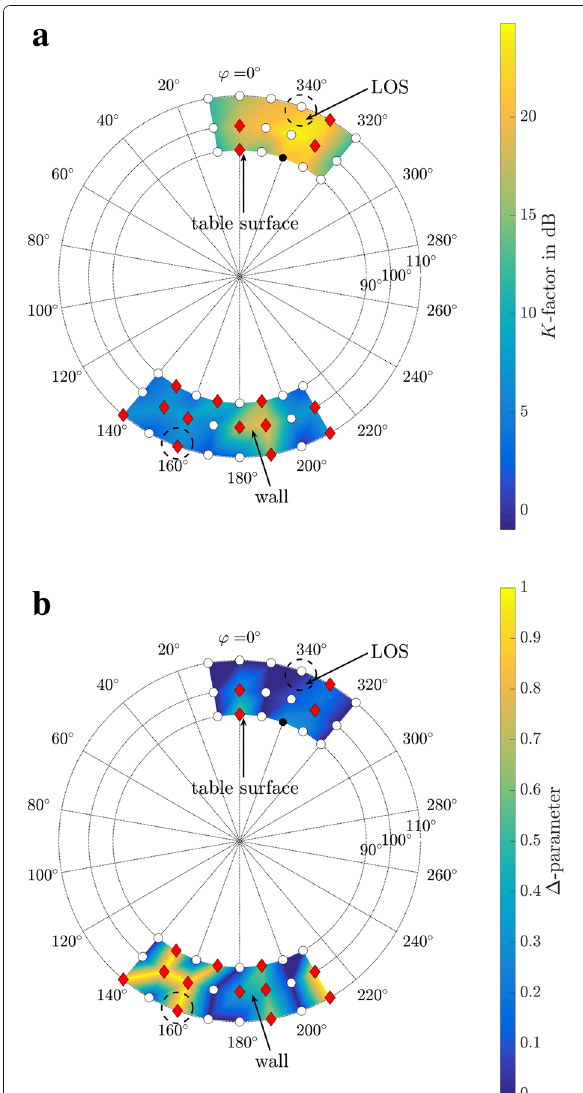
Fig. 12 Estimated K -factor ( a ) and Delta-parameter ( b ) of MC2. Due to the elevated position, the wall reflection has a 6dB increased K -factor as compared to MC1; see top part of Fig. 8. If the beam is not perfectly aligned, Rician fading turns again into TWDP fading. Wall reflections described by TWDP fading have a (cid:7) -parameter of close to one. The table surface reflection leads to a significantly smaller reflected component ( (cid:7) (cid:12) 1). The encircled sampling points are subject of further study in Sections 6 and 7. Markers have the same meaning as in Fig. 7